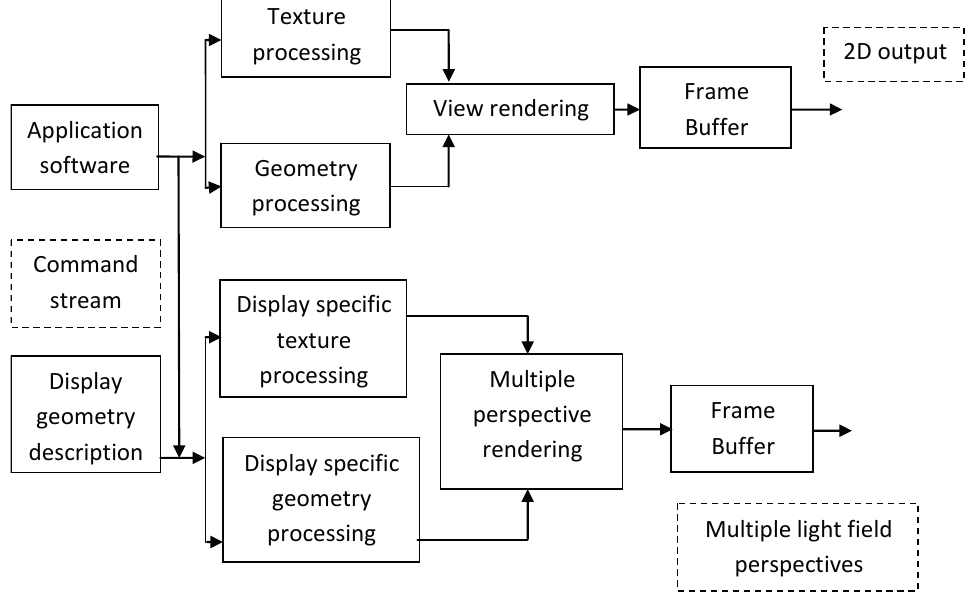
Figure 5. Light field rendering from OpenGL command stream: the various commands from application software are modified in real-time using the display geometry